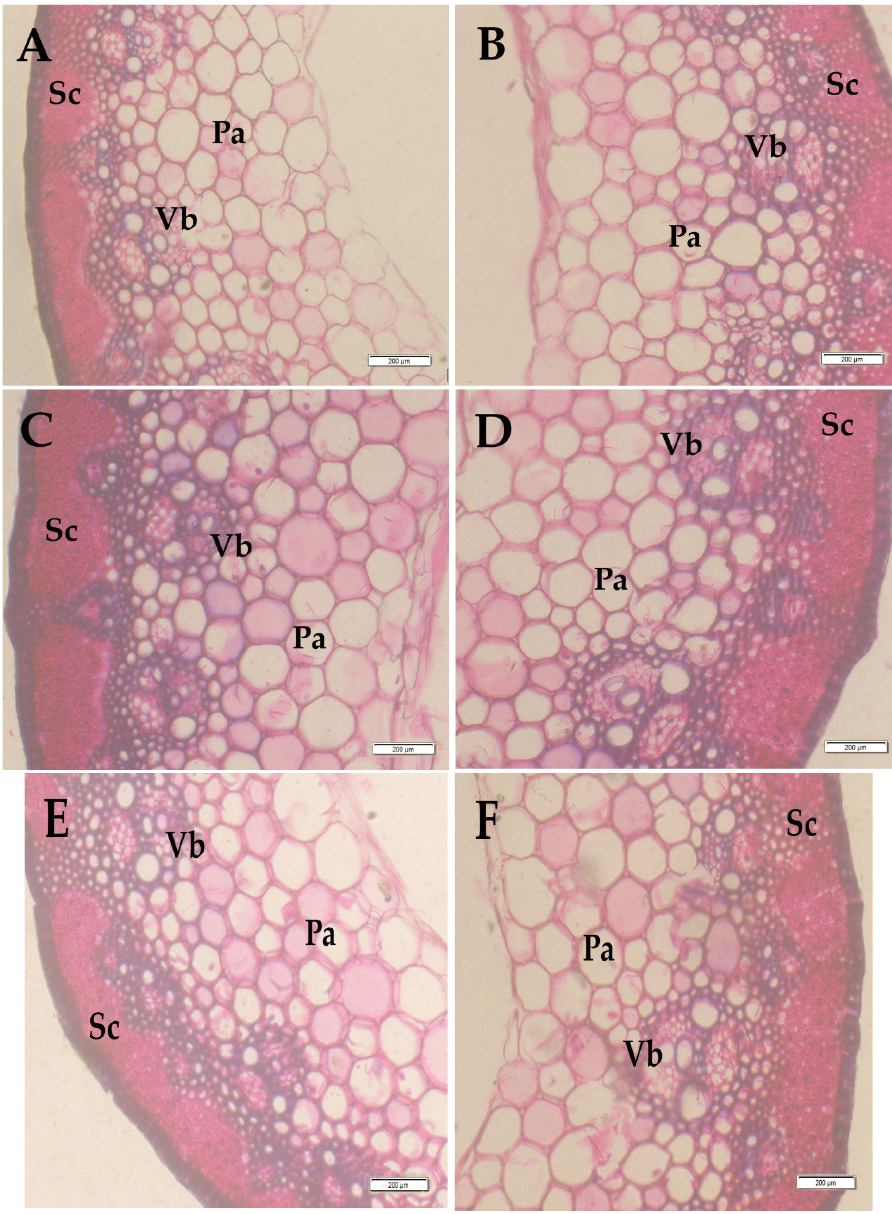
Fig. 1: Photographs of wheat stem section as affected by salicylic acid or proline application grown under normal and field deficit irrigation conditions. A) I 60 ; B) I 100 ; C) SA + I 60 ; D) SA + I 100 ; E) proline + I 60 ; F) proline + I 100 pa, parenchyma cells; sc, sclerenchyma cells; and vb, vascular bundle, scale bars = 200